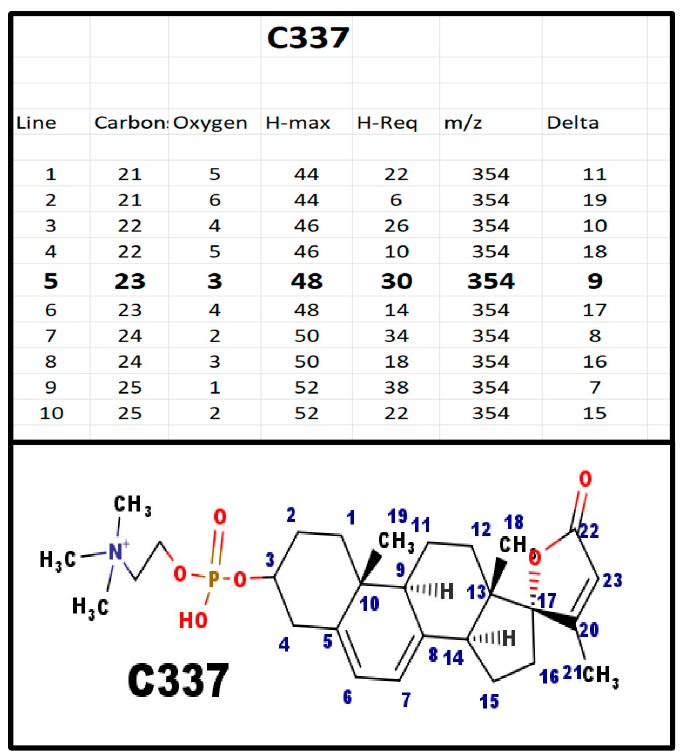
Figure A3. The proposed structures of C337.